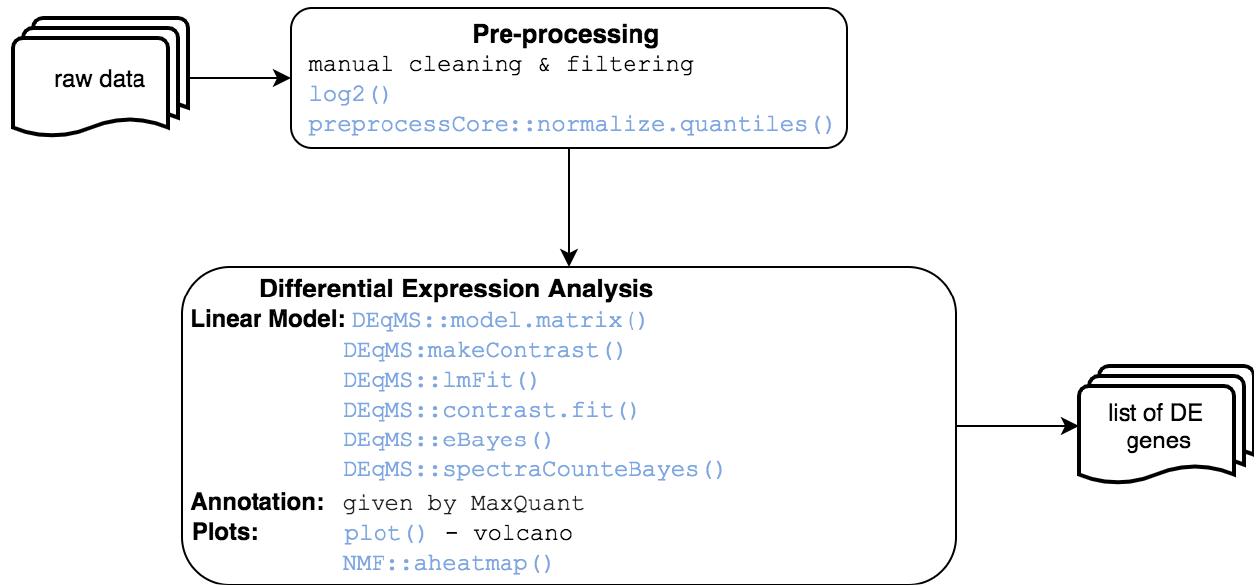
Figure 5. Proteomics analysis